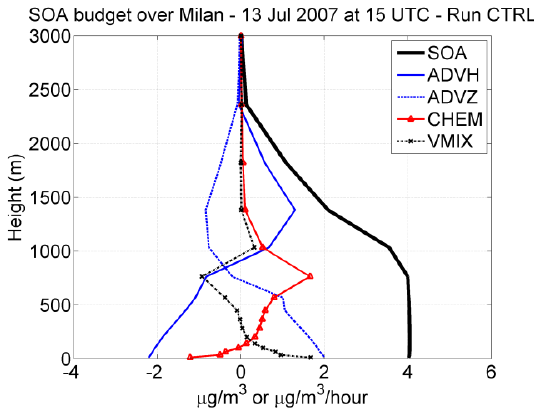
Figure 10. Same as Fig. 9 but for secondary organic aerosol (SOA).